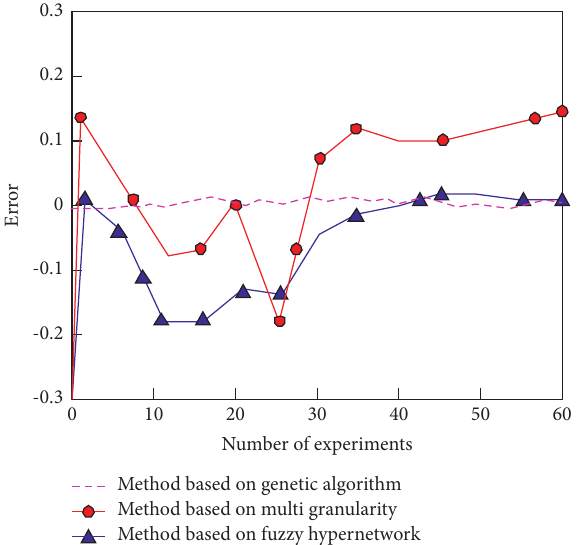
Figure 5: Comparison results of convergence of clustering algorithm.